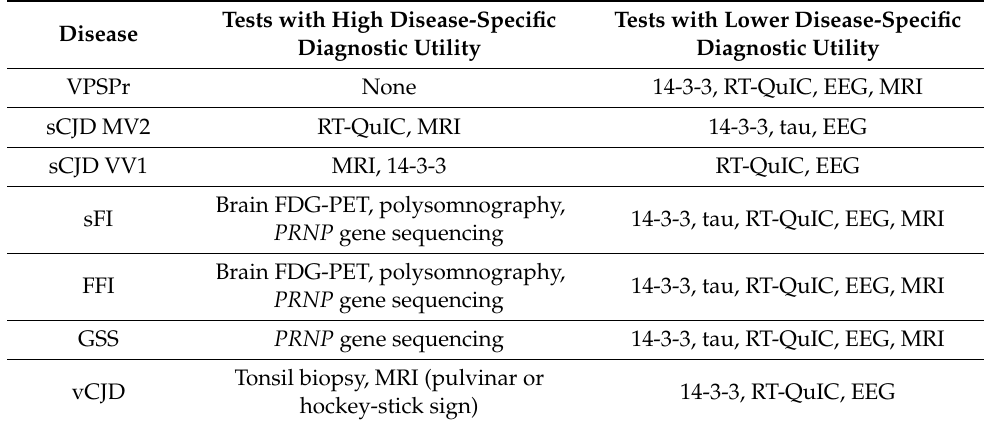
Table 3. Clinical Utility of Pre-mortem Diagnostic Testing in Atypical Prion